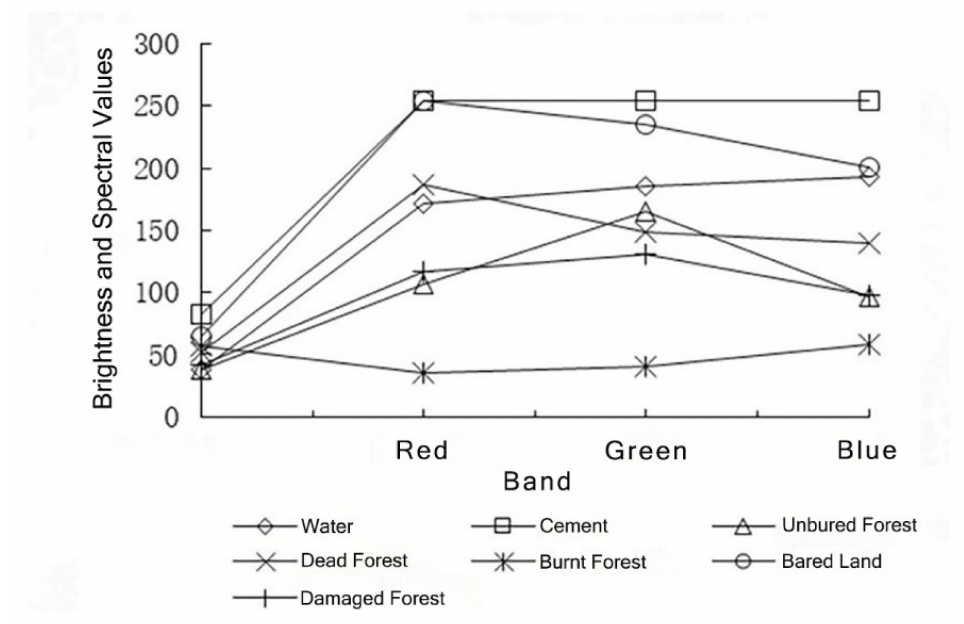
Figure 3. Responses of the average spectrum and brightness for various land